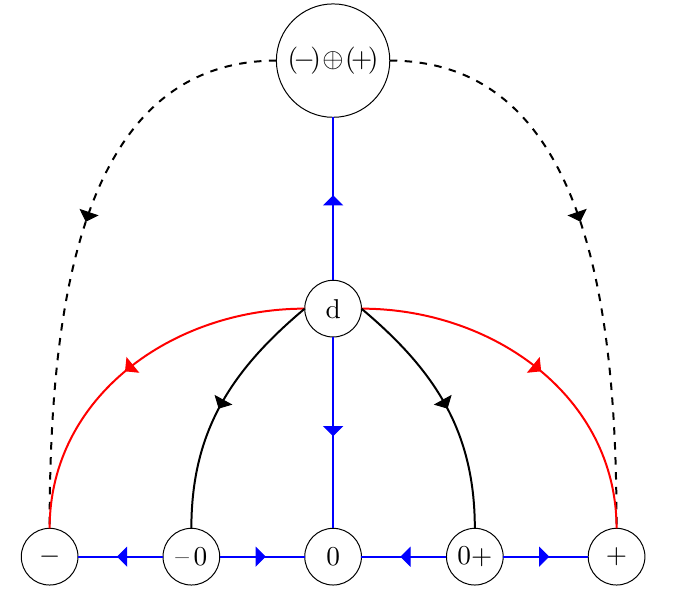
Figure 10. The space of boundary (cid:13)ows in the Tricritical Ising